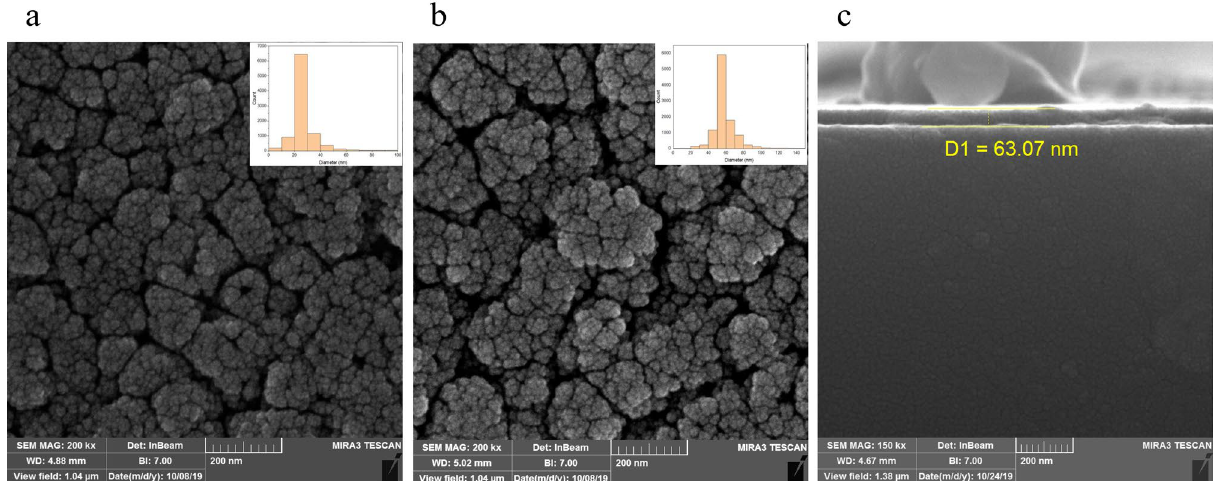
Figure 2. Top view of FESEM image of Ag NPs in ( a ) first layer, ( b ) second layer, ( c ) cross section of DLC